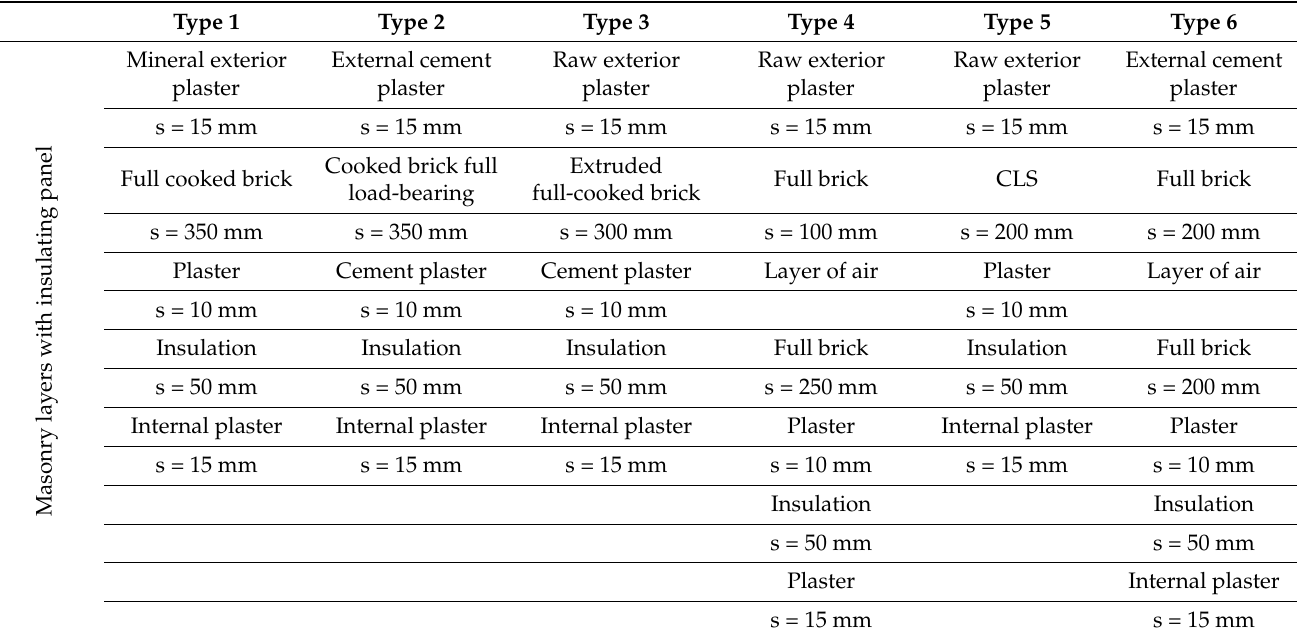
Figure 2. Introduction of the insulating panel in the various types of wall stratigraphy determined by TABULA by reference location. Table 3. Masonry layers of the individual building types (Figure